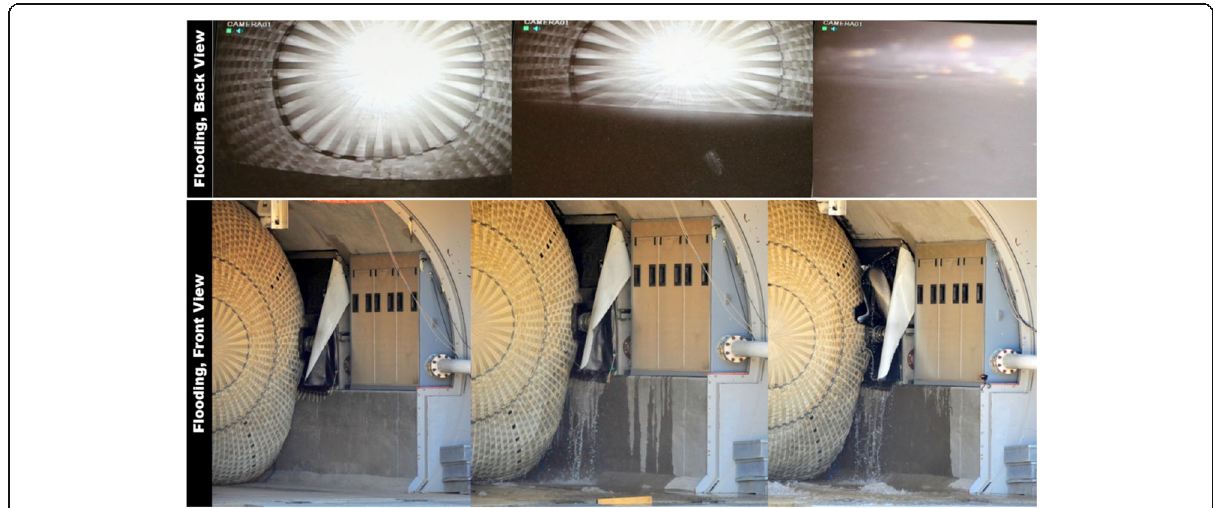
Fig. 15 Phase 3, full-scale testing, three-layer Vectran plug. Back view of the tunnel cavity during water filling for flooding simulation (top) and corresponding front view during flooding simulation (bottom) [91,